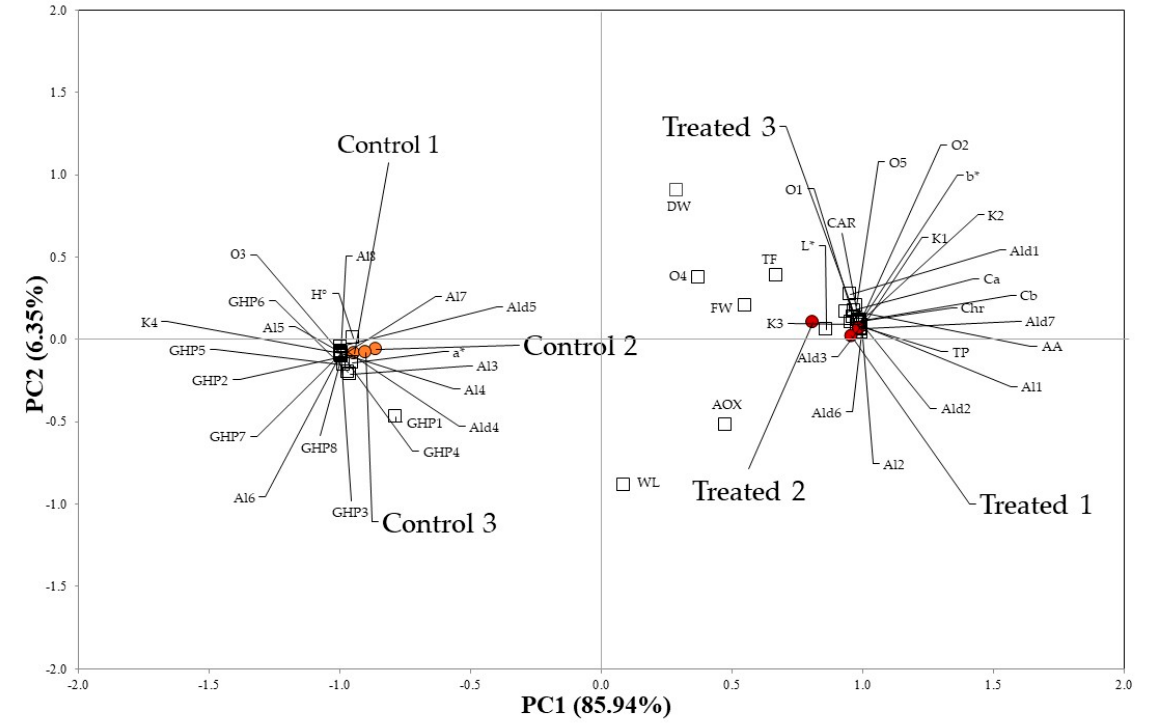
Figure 2. Principal component analysis performed on Ca, Cb, CAR, TP, TF, AA, AOX and on the semi-quantitative data (% RPA) of all VOCs detected in the rocket leaves treated with Bortan (Treated) and in the untreated samples (Control) (Codes are reported in the text and in Tables 1–3). The two components explained 92.3% of the variation in the dataset, since PC1 and PC2 accounted for 85.9% and 6.4% of the total variance, respectively. In the PCA plot, treated and control samples were clearly separated: rocket leaves grown in presence of the plant-based biostimulant are located in the right part of the score plot, with both PC1 and PC2 being positive (Figure 2). In contrast, control rocket samples are located in the left part of the PCA score plot, with both PC1 and PC2 being negative (Figure 2). These